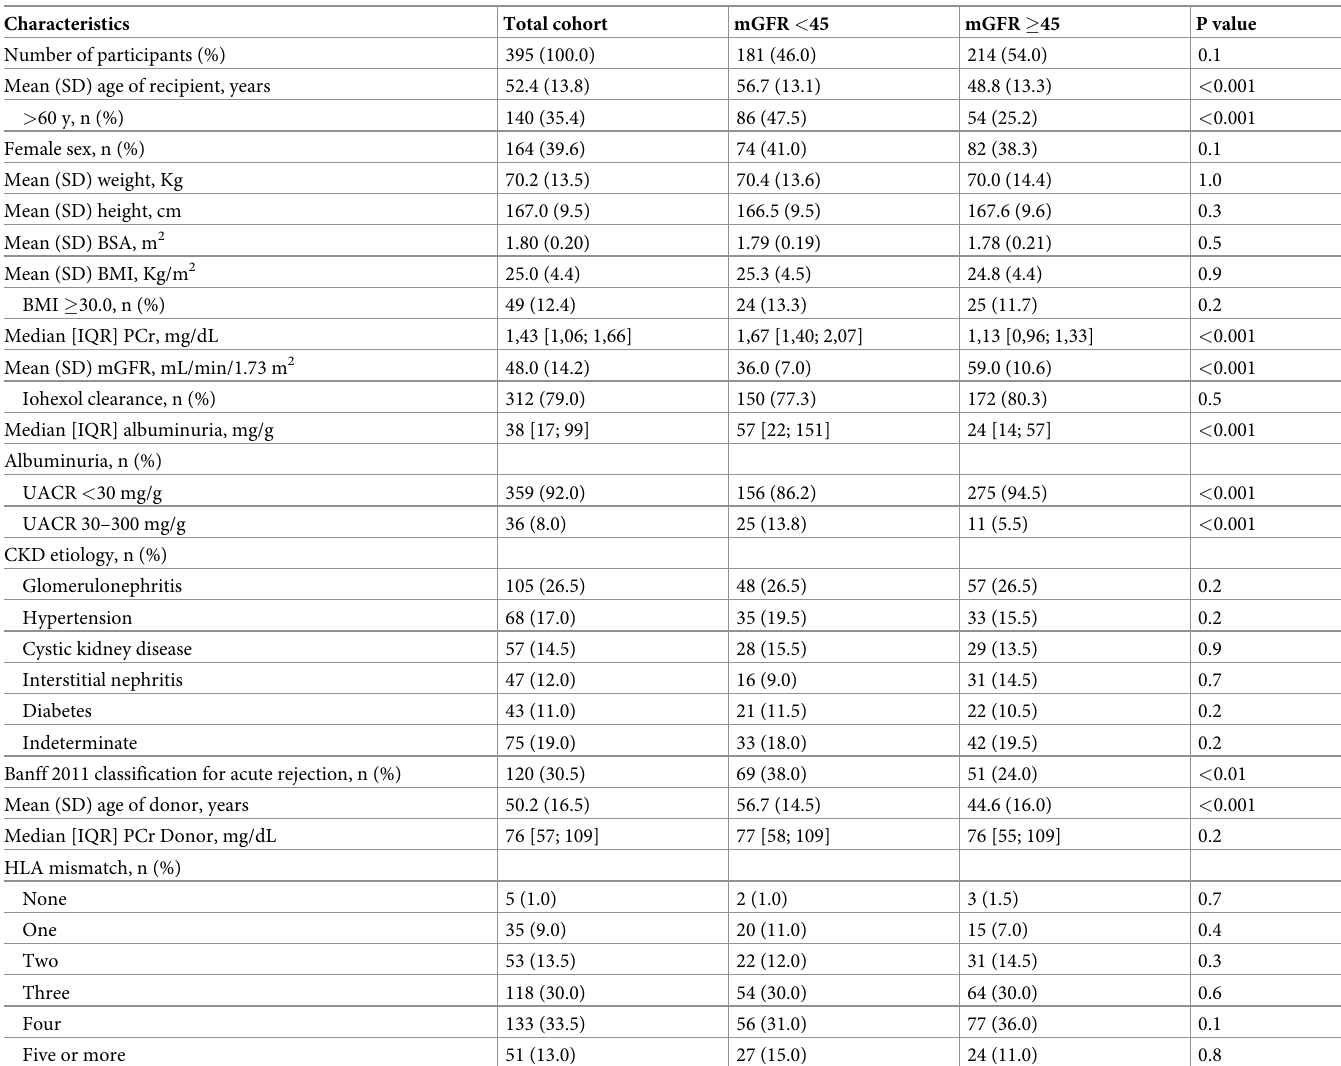
Table 2. Characteristics of the kidney transplanted